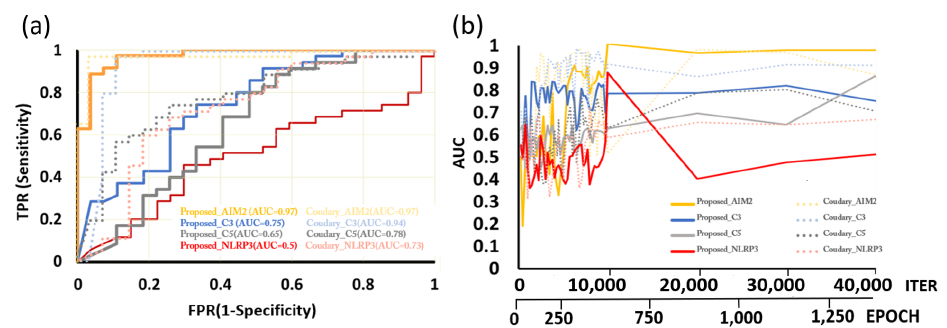
Figure 5. ( a ) Receiver operating characteristic (ROC) curves on the testing set for the models of the proposed method and the benchmark approach [44]; ( b ) Graphs of AUC on the testing set with respect to the iteration times in training among the DL models, showing that the Proposed-AIM2 model generally outperforms other models with the same training